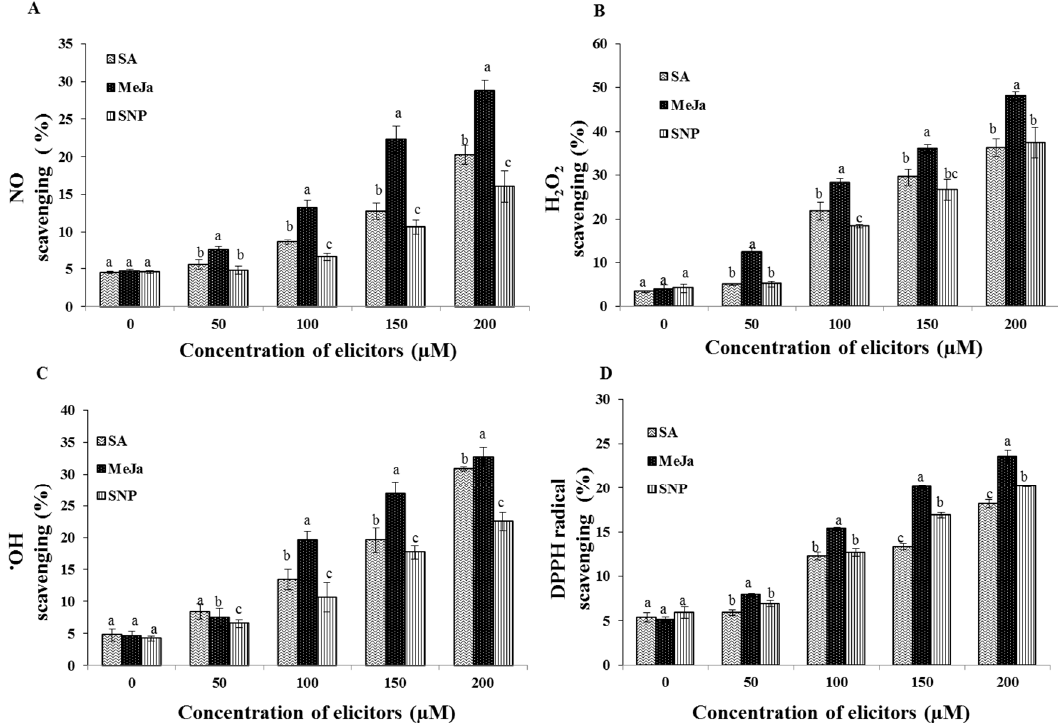
Figure 6. Effect of chemical elicitor treatments on free radical scavenging potentials of the extracts of cell suspension cultures. Nitric oxide scavenging potential ( A ); Hydrogen peroxide scavenging percentage ( B ); Hydroxyl radical scavenging capacity ( C ); DPPH radical scavenging potential ( D ) of cell extracts. Data are the mean ± SE from three replicates. Different letters (a, b, c) in one measurement indicate statistically significant difference at p ≤ 0.05 by Duncan multiple range test.